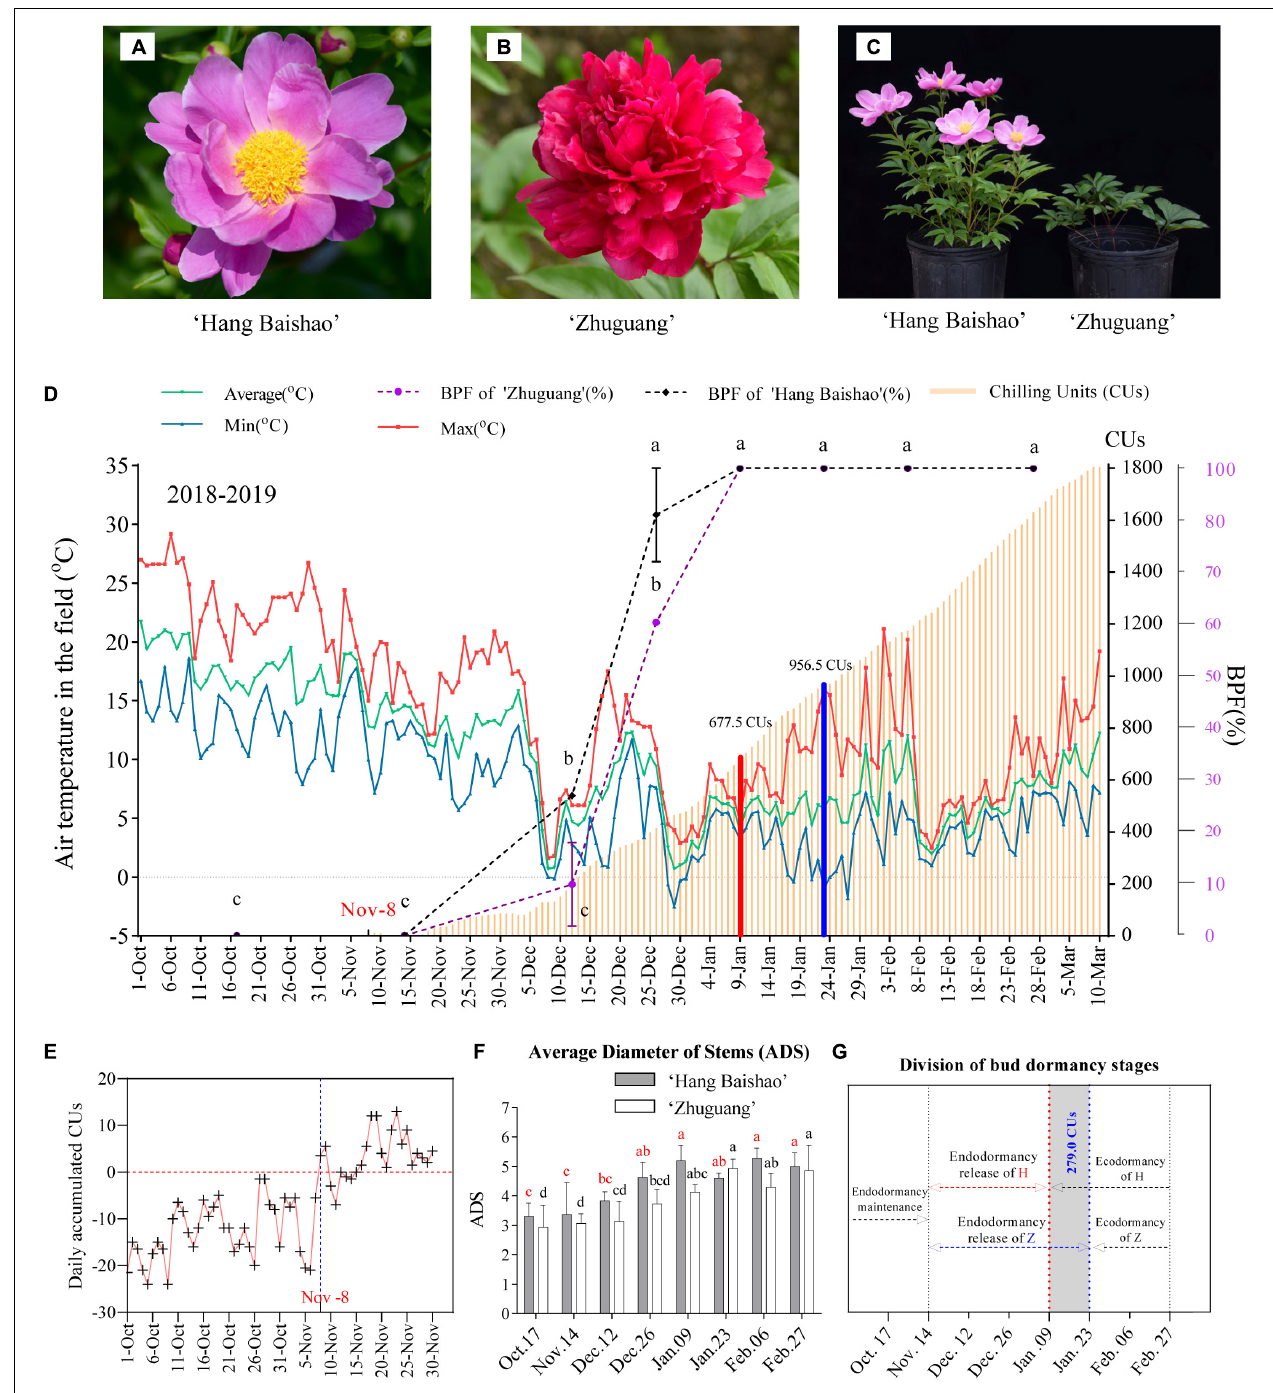
FIGURE 1 | Plant materials, CR evaluation and morphological observations in this study. (A,B) Plant materials ‘Hang Baishao’ and ‘Zhuguang’. (C) Performance of the two cultivars on the transport date January 09 after regrowth in the glasshouse. (D) Air temperatures, BPF and CR evaluation in 2018–2019. The date in red (November 08) was the start date of the CR evaluation. The line chart represents BPF. The CR value was 677.5 CUs on January 09 (red bar) and 956.5 CUs on January 23 (blue bar) for ‘Hang Baishao’ and ‘Zhuguang,’ respectively. Error bars represent the standard deviation from three biological replicates, and different letters indicate significant differences ( P < 0.05). Differences were compared among different move dates for each cultivar. (E) Daily accumulated CUs for determining the start time of CR evaluation. November 08 was the date on which the daily accumulated CUs first became positive. (F) Morphological index ADS of the two cultivars. (G) Division of bud dormancy stages of the two cultivars. Dashed lines indicate the division of bud dormancy stages, H represents ‘Hang Baishao’ and Z represents ‘Zhuguang.’ The gray shaded part represents the CR difference between the two cultivars, which was 279.0 CUs.